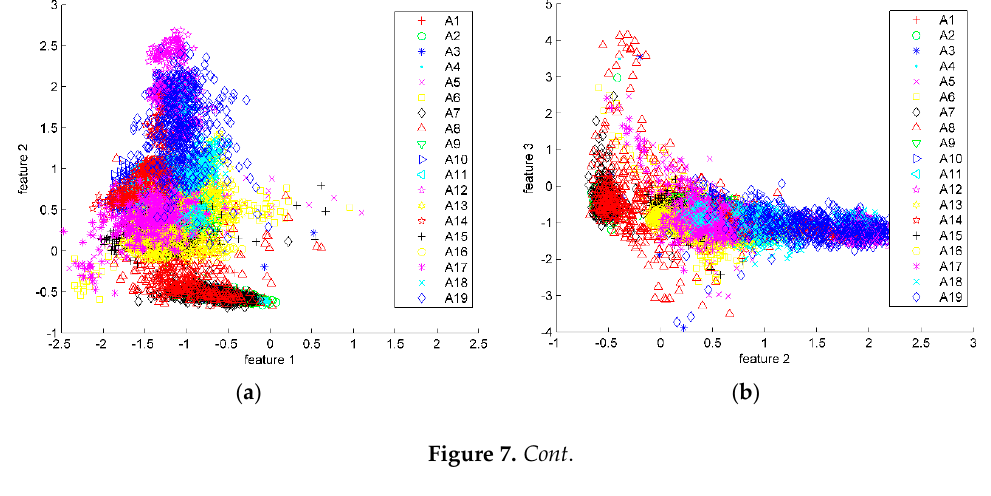
Figure 7. Cont . Figure 7. Cont .